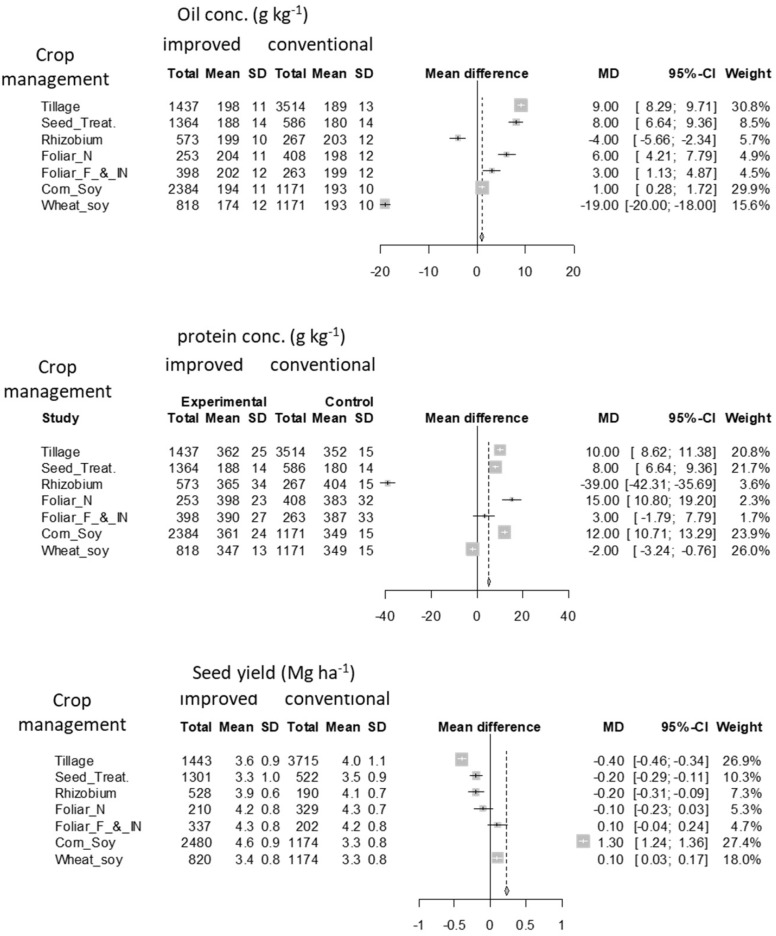
A detailed forest plot for the effect of improved tillage, seed treatment, rhizobium inoculation, foliar N application, foliar fungicide and insecticide application, corn-soybean, and spring wheat-soybean double crop rotation over conventional approaches on oil concentration, protein concentration, and seed yield. Light symbols with square box in mean difference represent factors with greater weight and black dot with a standard error bar represent factors with less weight. The weights of each factor and dotted line in mean difference were important points to discuss if an overall factor effect and comparison of factors was the objective, however, the intention of the current analysis is only to present the individual management (M) factor effect.